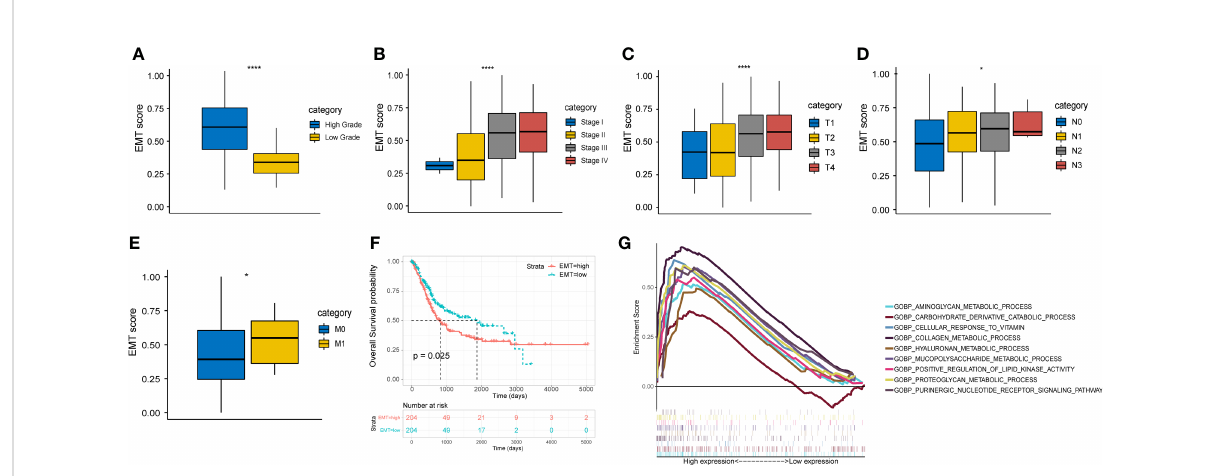
FIGURE 1 EMT score shows important clinical prognostic value and biological implication in TCGA cohort. (A-E) The correlation between EMT score and grade, clinical stage and AJCC TNM stage. (F) Comparison of overall survival between high and low EMT score groups. (G) Multiple metabolic regulatory pathways were signi fi cantly enriched in the high EMT score group. * p<0.05, ****